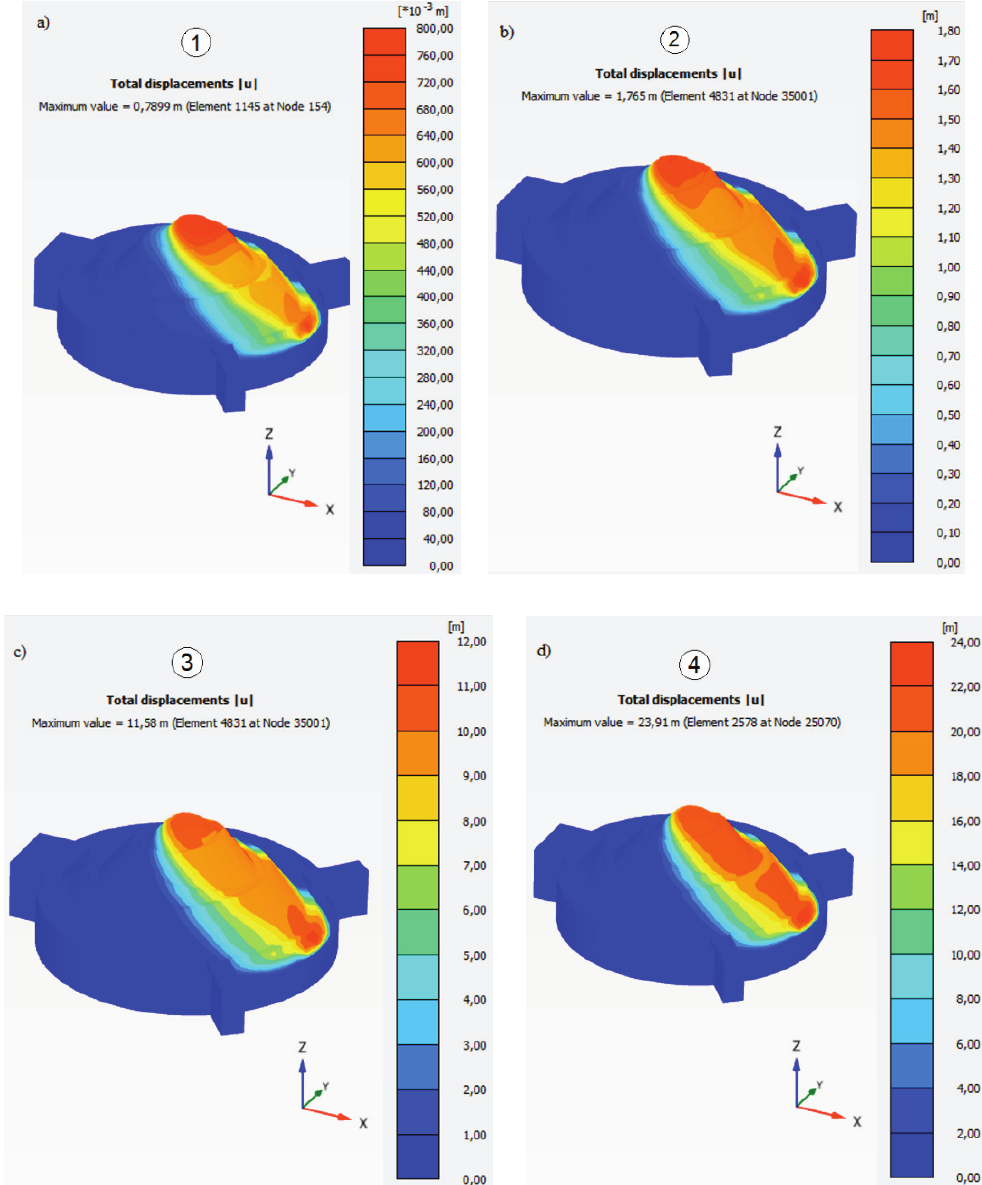
Fig. 12. Total displacements for (a) 2%, (b) 3%, (c) 5%, (d) 7% reduction of cohesion and tangent of friction angle